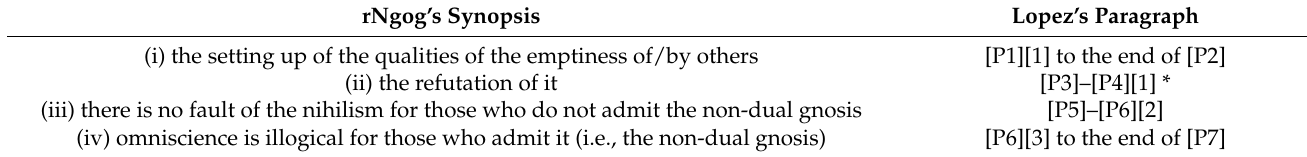
Table 1. The rNgog’s and Lopez’s understanding of the paragraph of the PHT (D273a7–274b2), which the rNgog calls “the denial of the other’s system, which is the second [explanation on the particularity of